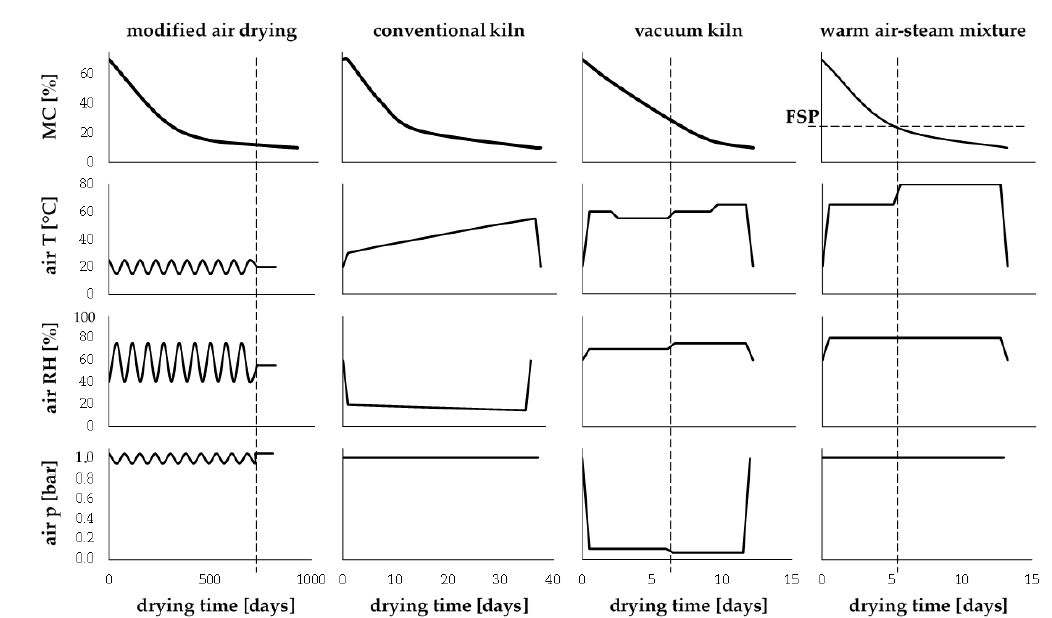
Figure 1. Schematic of schedules for dying experimental beech samples with four studied Figure 1. schematic of schedules for dying experimental beech samples with four studied processes.